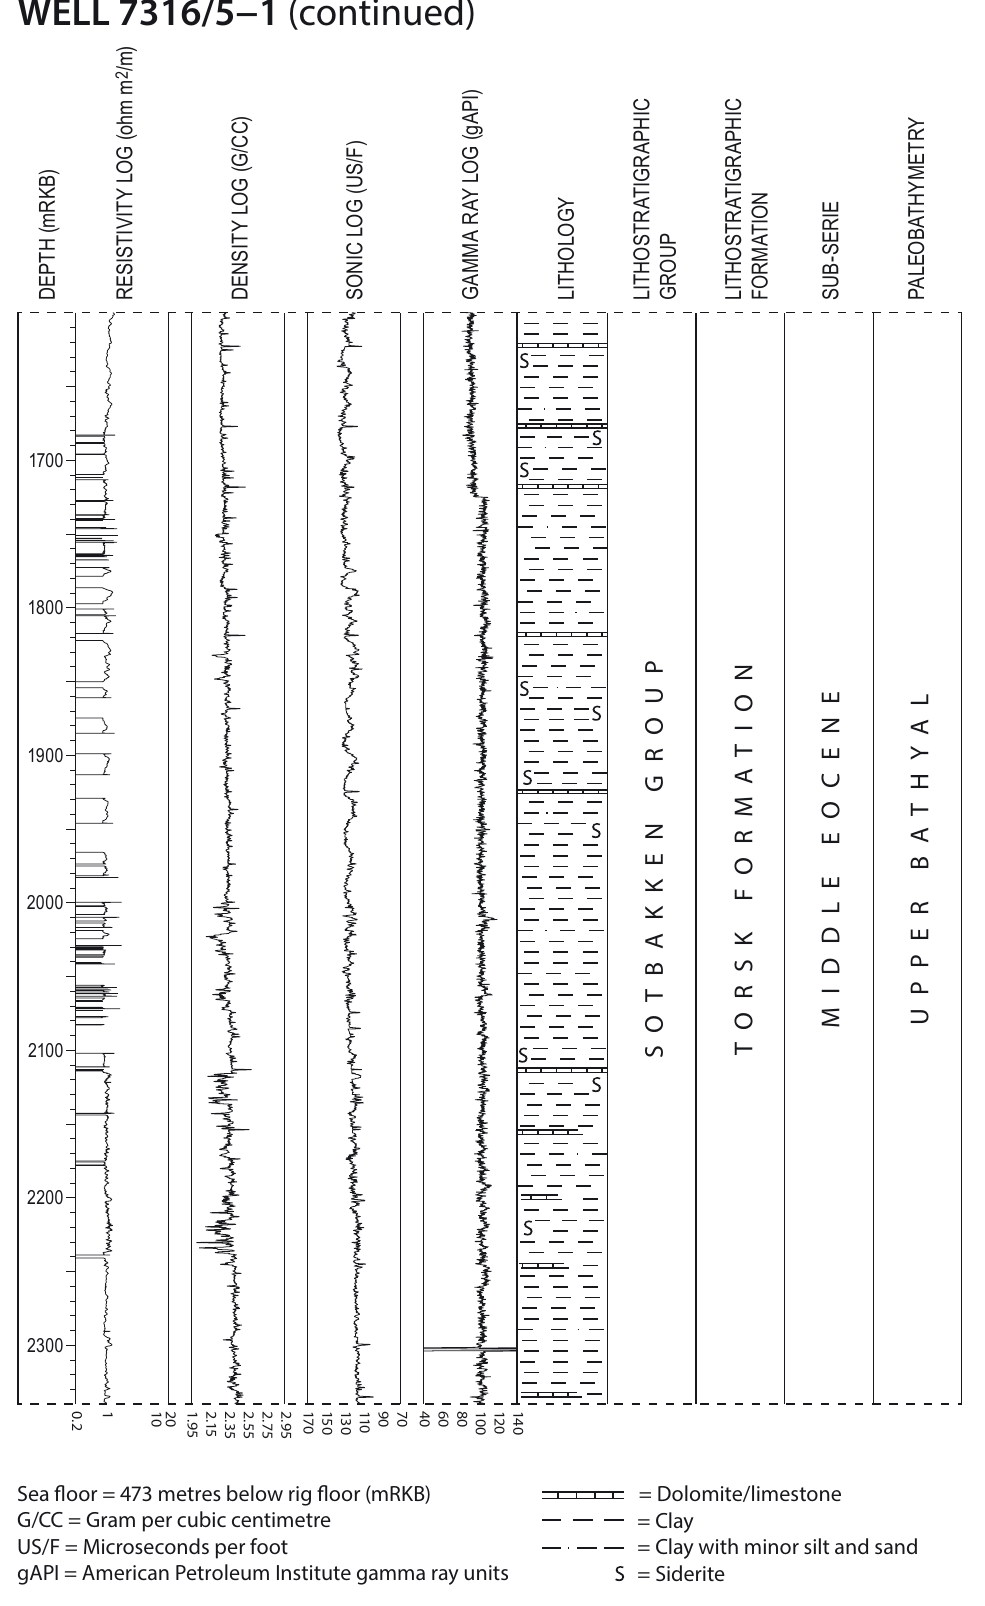
Figure 12. Well summary figure for well 7316/5–1 including resistivity log, density log, sonic log, gamma-ray log, Fig. 12 lithology, lithostratigraphic units, sub-series, and paleobathymetry for the second-bottom part of the supplementary well reference section for the Torsk Formation (middle Eocene; modified after NPD factpages